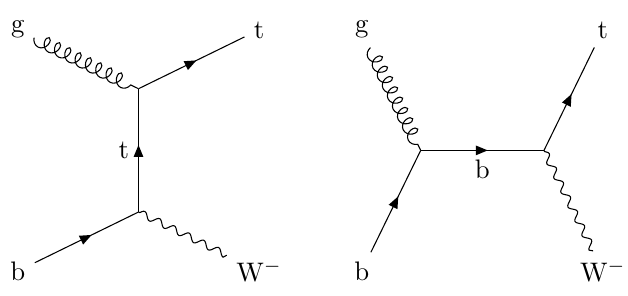
Figure 1 . Leading-order Feynman diagrams for single top quark production in the tW channel. Charge conjugate states are